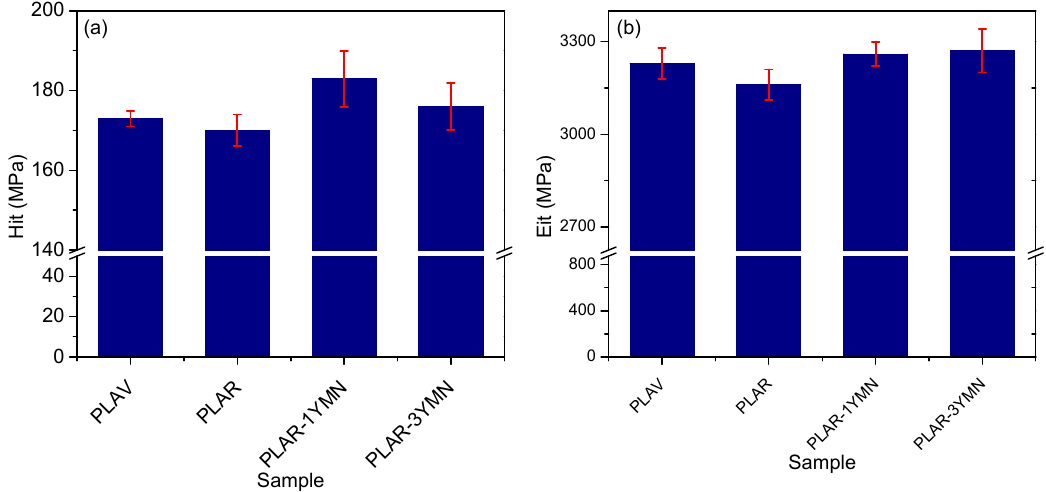
Figure 12. Indentation hardness ( a ) and Young modulus ( b ) of the different samples.